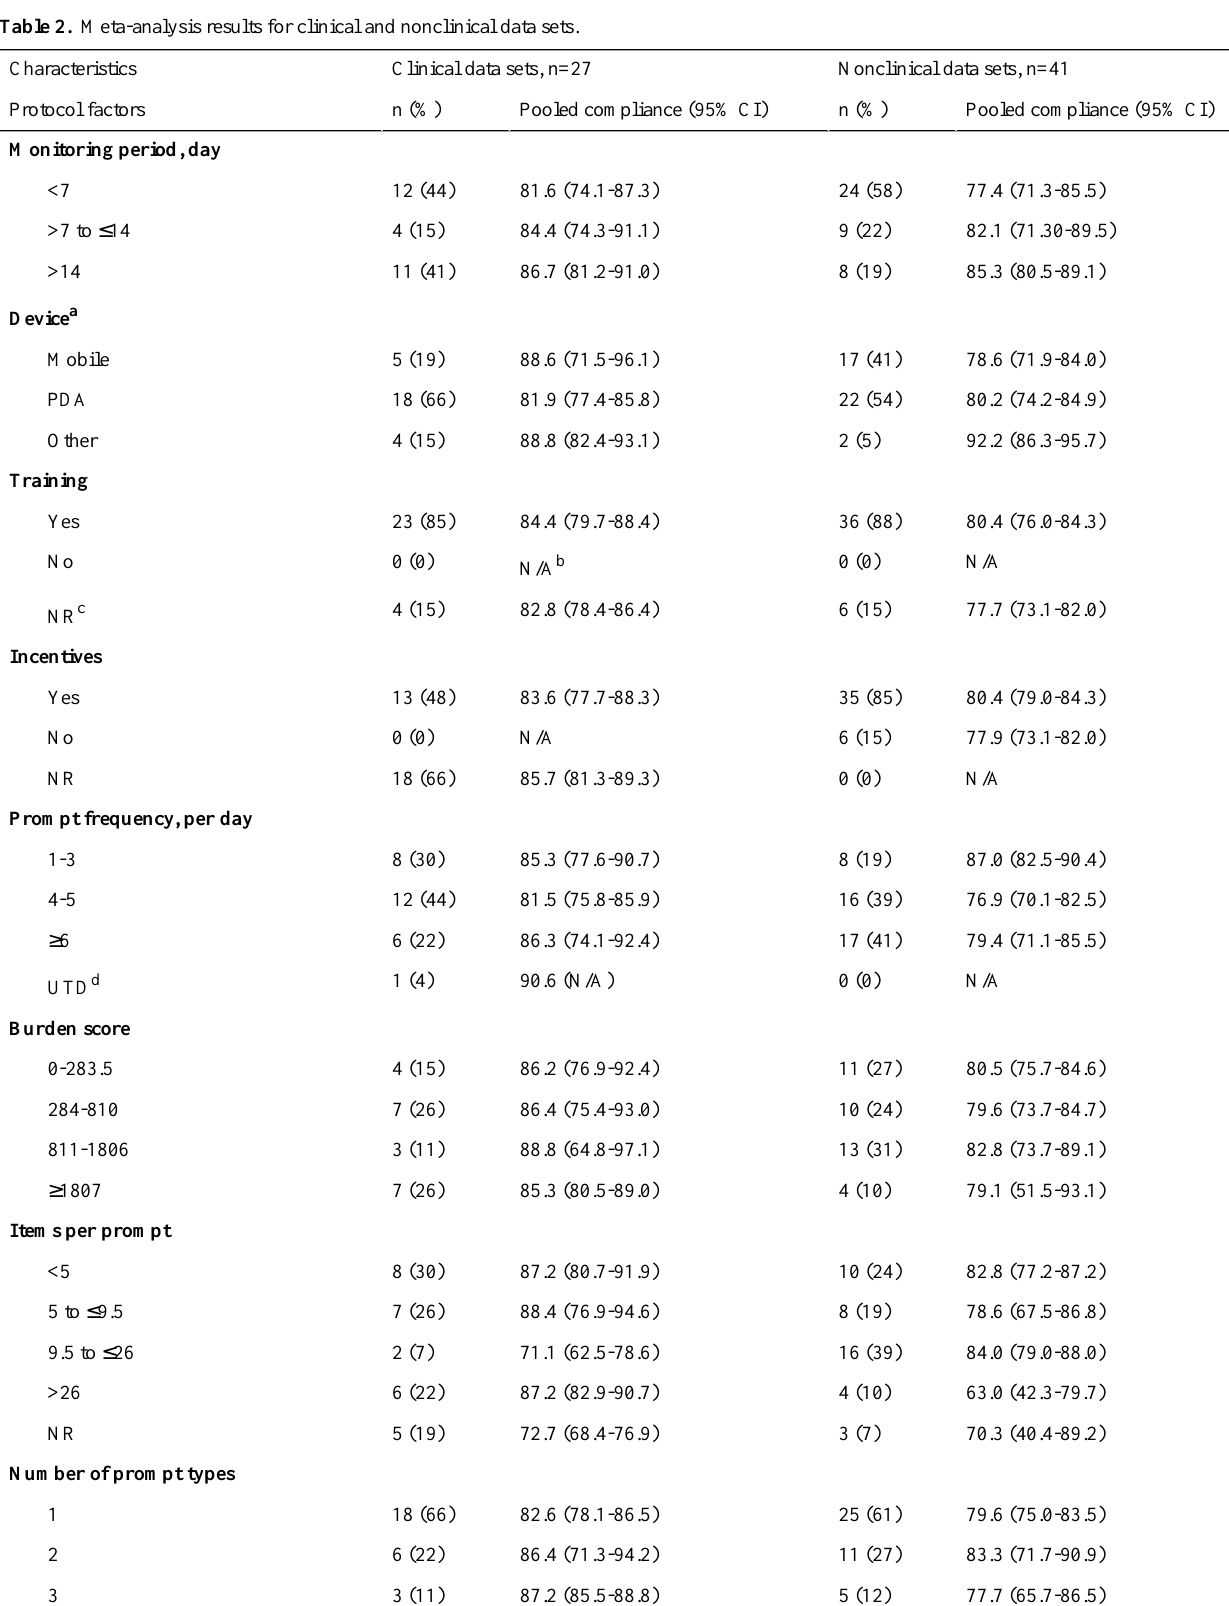
Table 2. Meta-analysis results for clinical and nonclinical data sets.